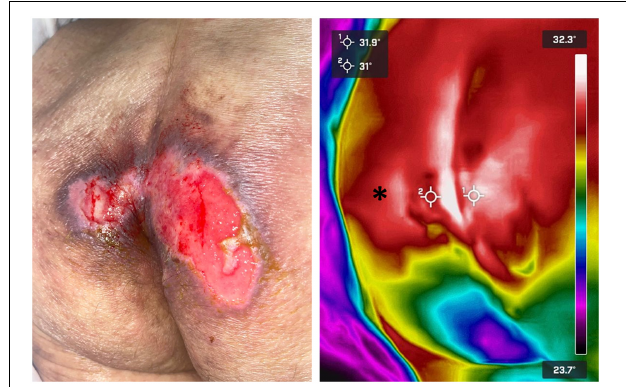
FIGURE 5 | Pressure ulcer thermographic assessment. Infrared thermography was used to assess the severity of a sacral pressure ulcer in a bedridden patient. The wound’s temperature (crosshairs) was found to be very similar to the surrounding healthy skin (asterisk). Thermal gradients close to 0 ◦ C are highly suggestive of wounds that will re-epithelize by themselves in a relatively short term. Images, courtesy of Dr. Mario A. Martinez-Jimenez, were acquired using a FLIR One Pro